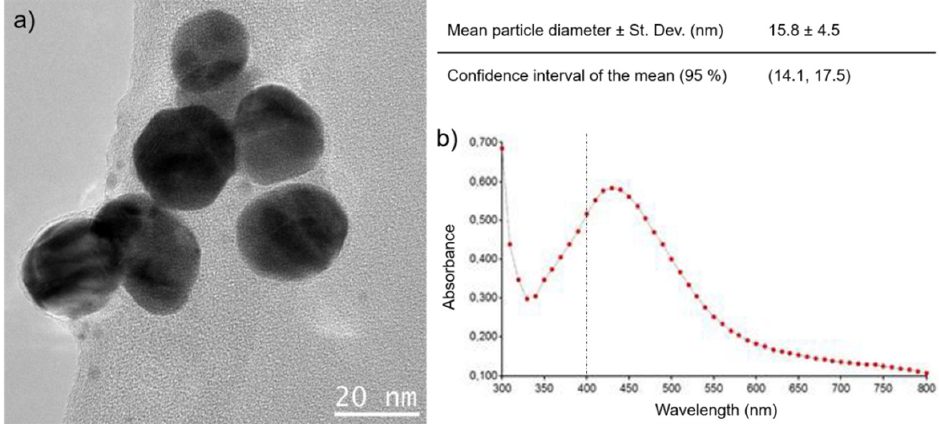
Figure 3. Characterization of AgNPs, ( a ) TEM experiment showing particle’s morphology, size distribution, and ( b ) spectrophotometry study of the particle suspension stability.